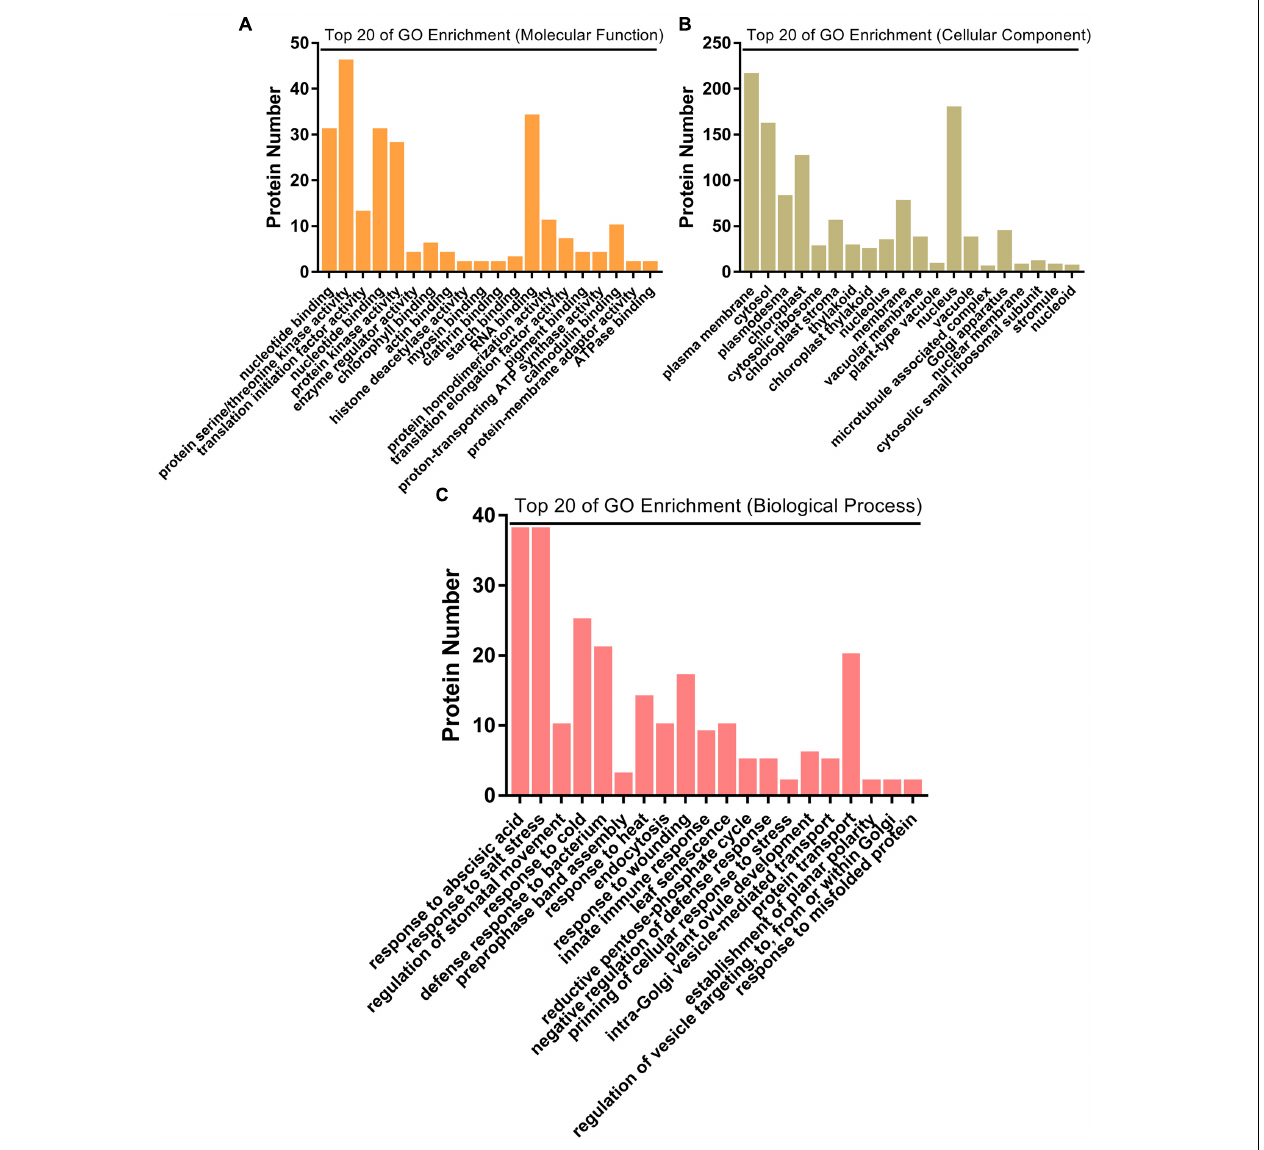
FIGURE 4 | GO enrichment analysis of significantly changed phosphoproteins. (A) Top 20 of GO enrichment analysis on molecular function. (B) Top 20 of GO enrichment analysis on cellular component. (C) Top 20 of GO enrichment analysis on biological